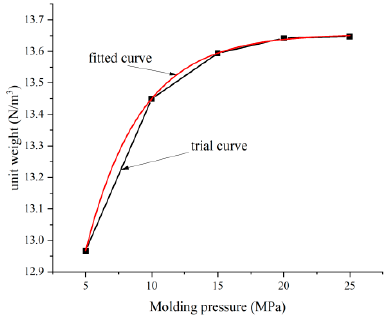
Figure 8. Effects of molding pressure on density.